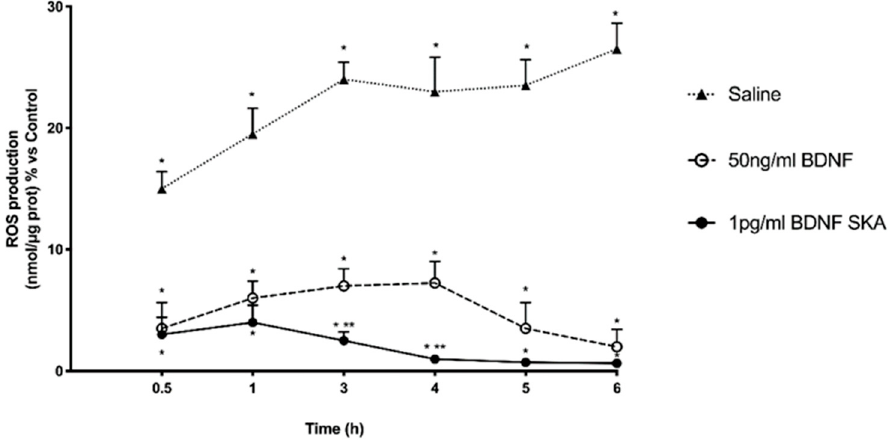
Figure A2. ROS production at intestinal barrier. Data are expressed as means ± SD (%) of five independent experiments performed in triplicates (0 line as control). Saline = saline solution. * p < 0.05 vs. control, ** p < 0.05 vs. 50 ng / mL BDNF.